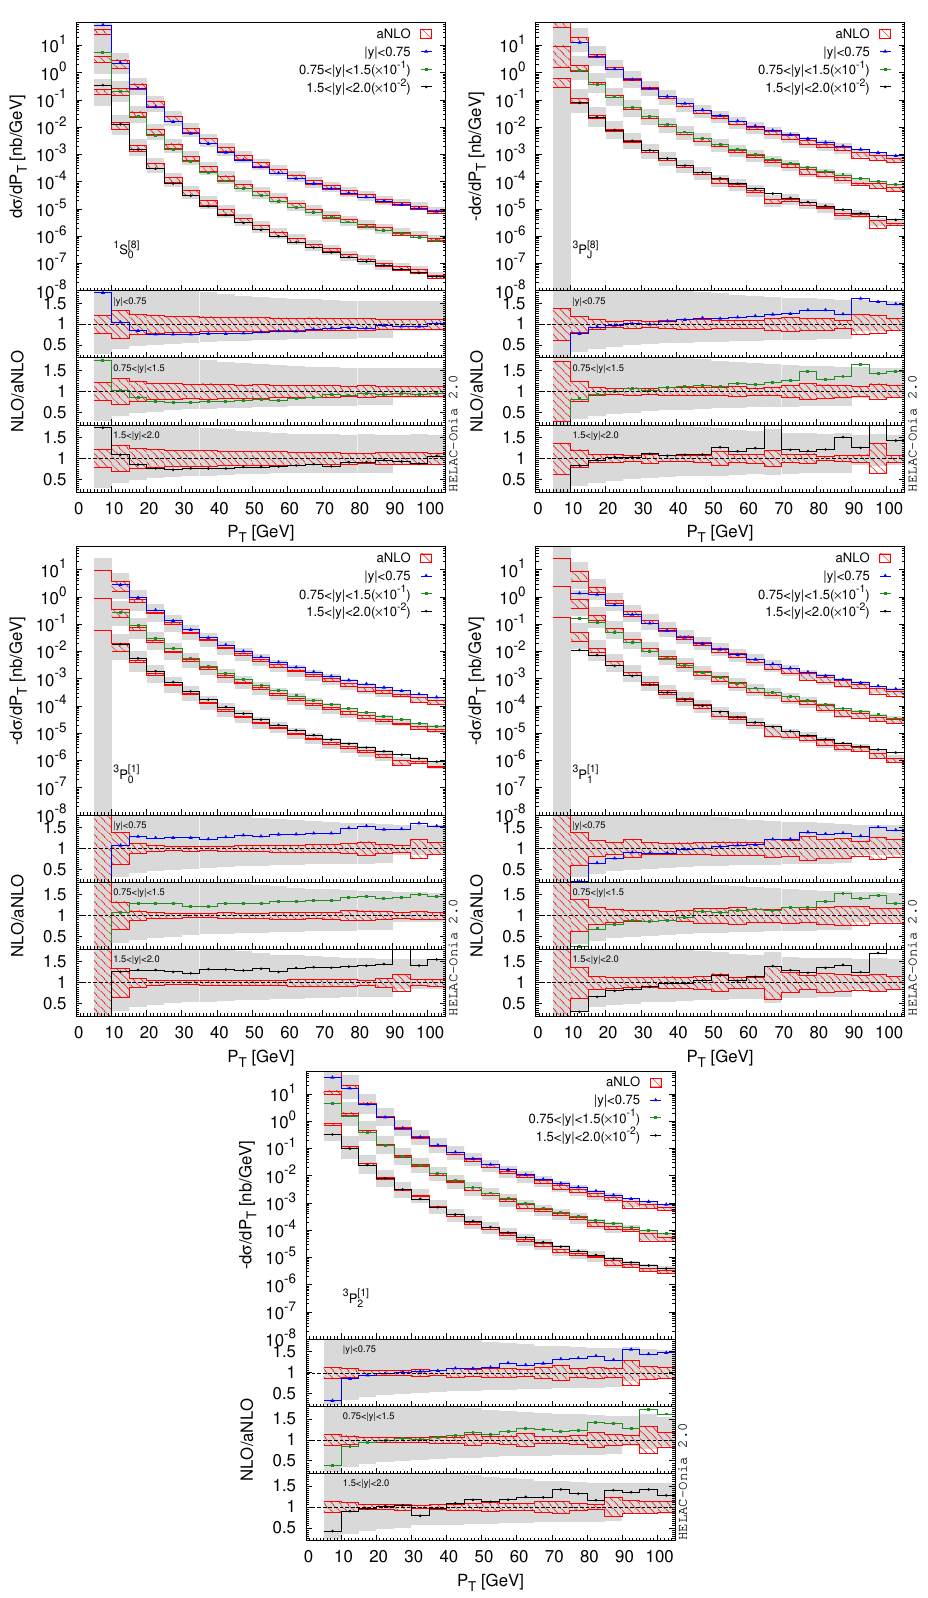
Figure 18 . Comparisons of spin-summed differential cross sections for the Fock states 1 S [8] 3 P [1] , 3 P [1] , 3 P [1] between our aNLO calculations and the complete NLO calculations. They are 0 1 2 similar to figure